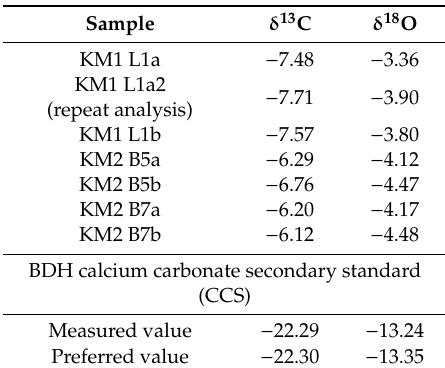
Table 7. δ 13 C and δ 18 O stable isotope values of carbonate minerals in the KM bentonites.